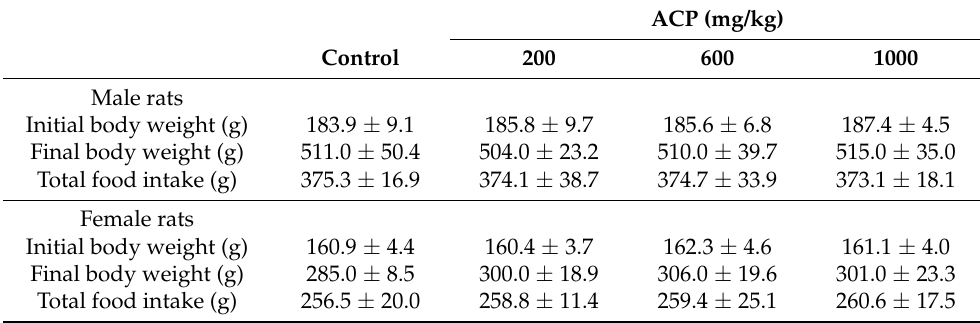
Table 1. Changes in body weight and food intake of male and female rats treated with or without ACP for 90 days.